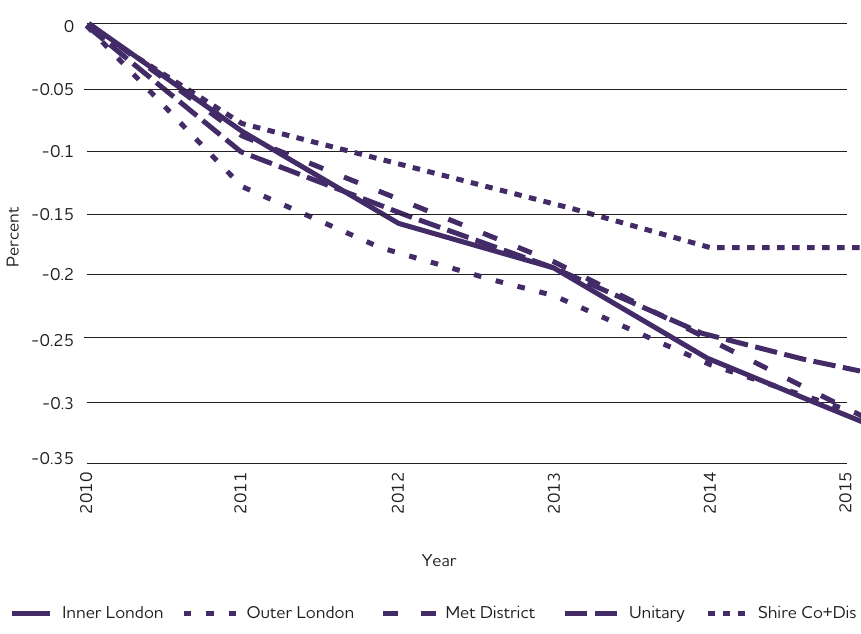
Figure 1: Cumulative Real Change in Spending Power by Class of Authority, England